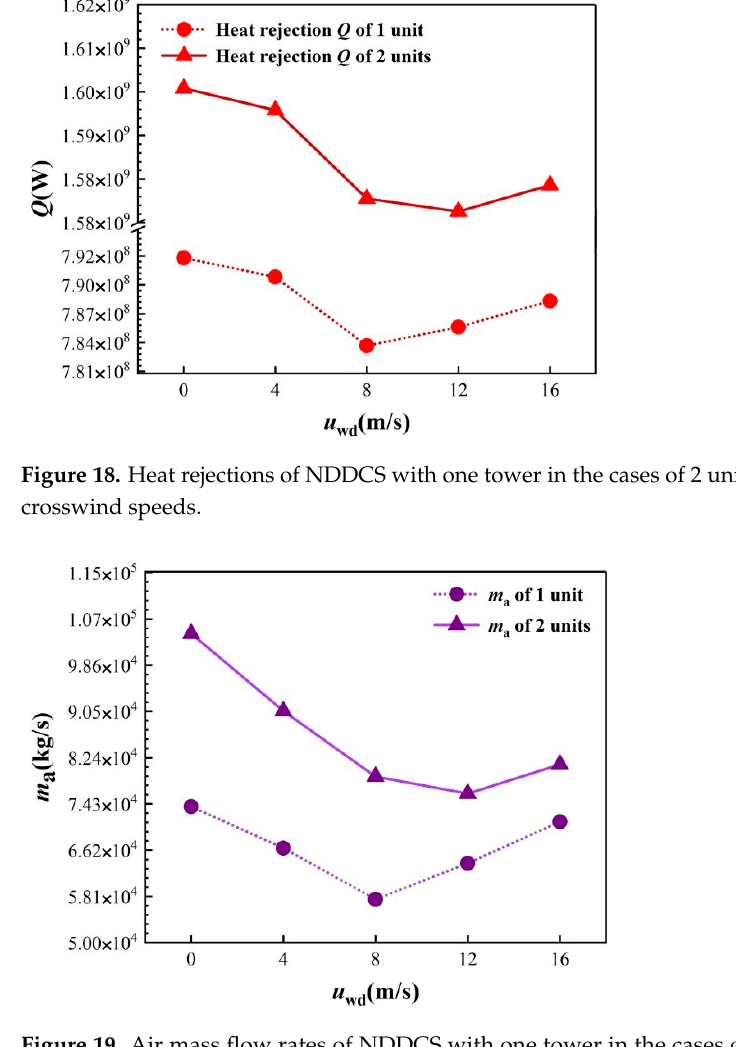
Figure 20. Water outlet temperatures of ACHE in the cases of 2 units and 1 unit under typical crosswind speeds. Figure 21. Turbine back pressures in the cases of two units and one unit under typical crosswind speeds.